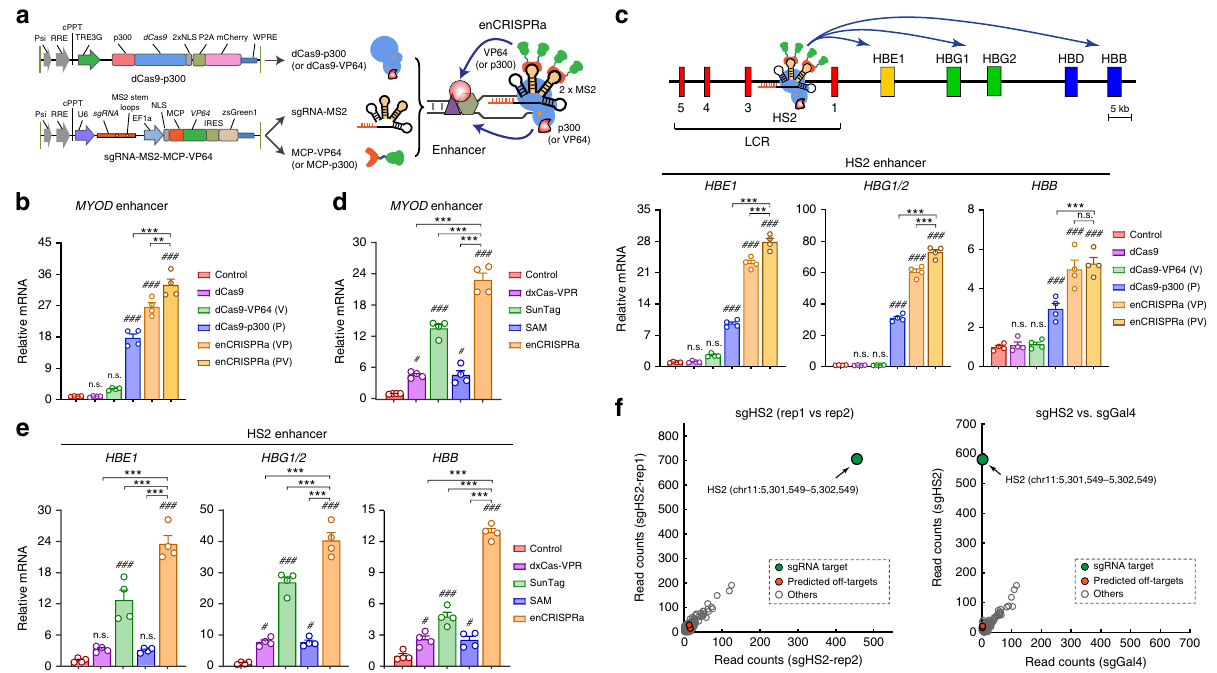
Fig. 1 Development of the dual-activator enCRISPRa system. a Schematic of enCRISPRa containing three components: a dCas9-p300 fusion protein, the sgRNA with two MS2 hairpins, and the MCP-VP64 fusion protein. b Expression of MYOD upon dCas9 alone, dCas9-VP64 (V), dCas9-p300 (P), dCas9- VP64 + MCP-p300 (enCRISPRa-VP) or dCas9-p300 + MCP-VP64 (enCRISPRa-PV)-mediated enhancer activation in HEK293T cells. mRNA expression relative to nontransduced cells (control) is shown as mean ± SEM ( n = 4 experiments). The differences between control and dCas9 activators were analyzed by a one-way ANOVA. # P < 0.05, ### P < 0.001. The difference between different dCas9 activators were analyzed by a one-way ANOVA. * P